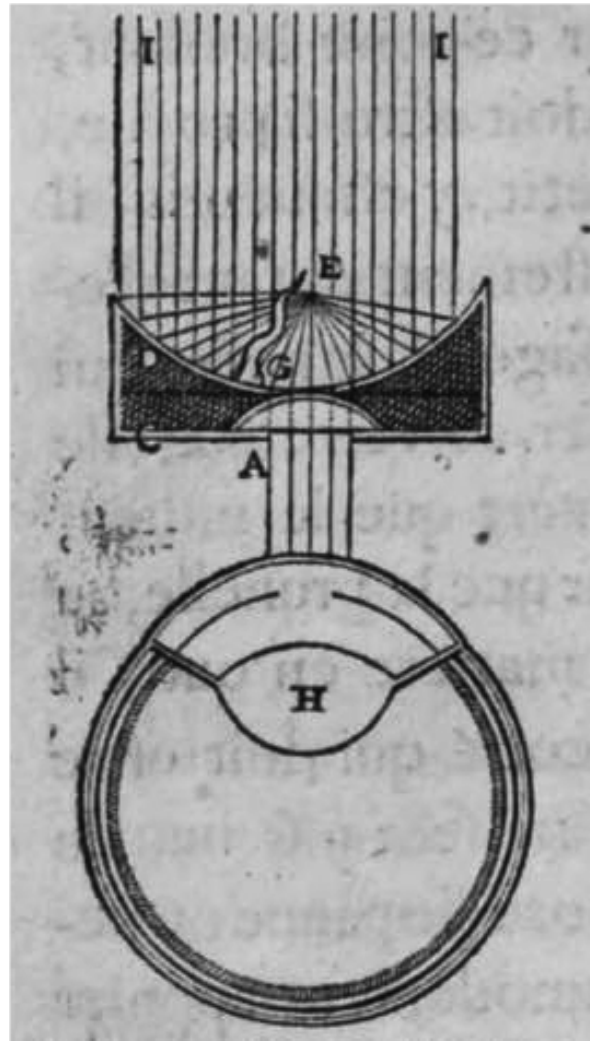
Figure 3. Descartes design for an instrument to amplify and visualize small objects. He described ( La Dioptrique [9 th Discourse — Des Lunettes ]) a lunette ( lunete ), an unilenticular instrument, where solar rays (I) are focused on the object (E) supported by a small arm (G), by a concave mirror (D) with a central transparent area behind which is placed the crystal ( verre ) [lens] (A), embedded in a supporting structure (C). The rays are first reflected to the object, and then, from the object to the eye (H).